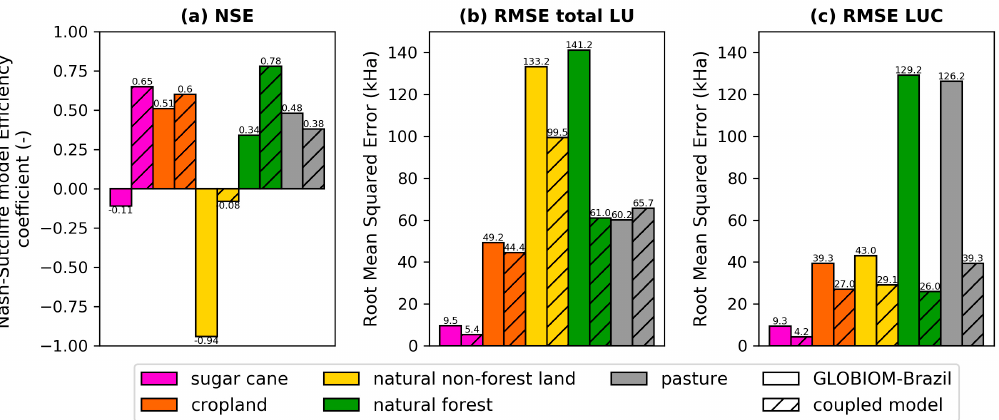
Figure 5. ( a ) The Nash–Sutcliffe efficiency (NSE), ( b ) Root Mean Squared Error (RMSE) of total land use in 2015 and ( c ) of land use change from 2007 to 2015. The three validation metrics are computed for Mato Grosso between the model projections (with GLOBIOM-Brazil and the coupled model) and the observations.